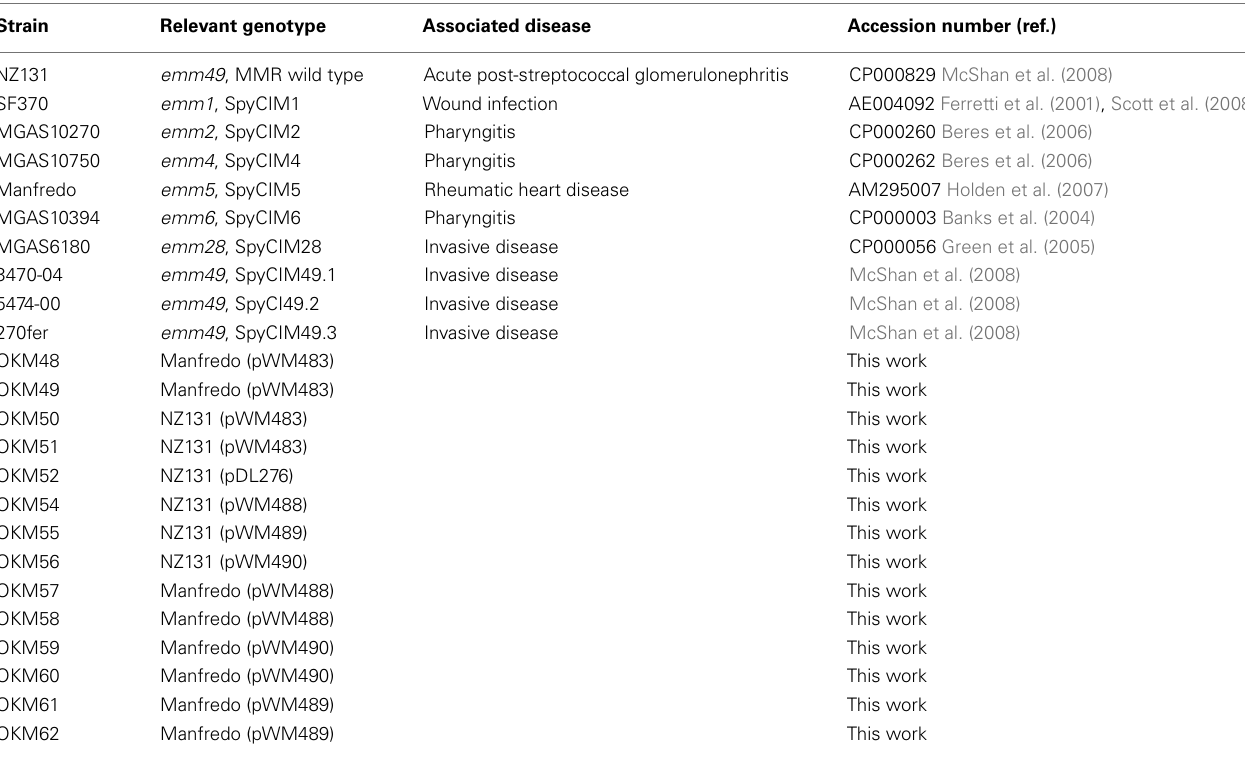
Table 1 | Streptococcus pyogenes strains used in this